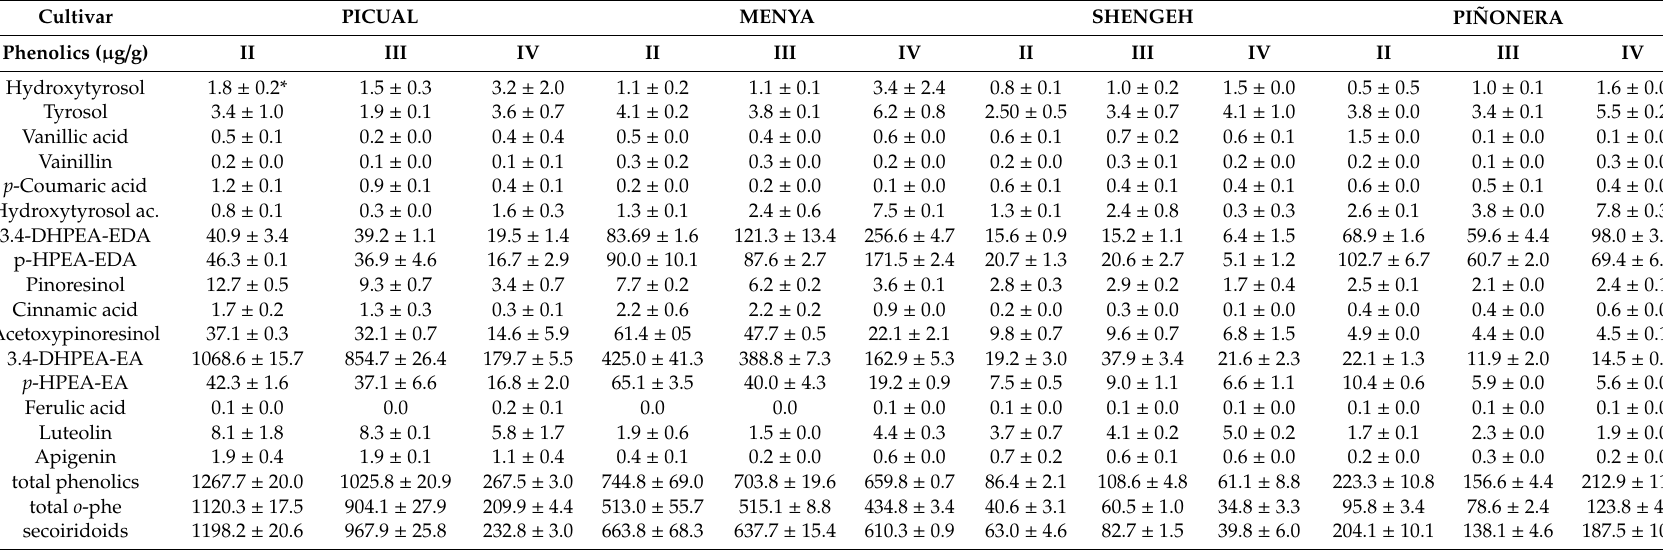
Table 2. Concentration of phenolic compounds ( µ g / g oil) in virgin olive oils (VOOs) obtained from fresh olive fruits (Picual, Menya, Shengeh, and Piñonera cultivars) harvested at di ff erent ripening